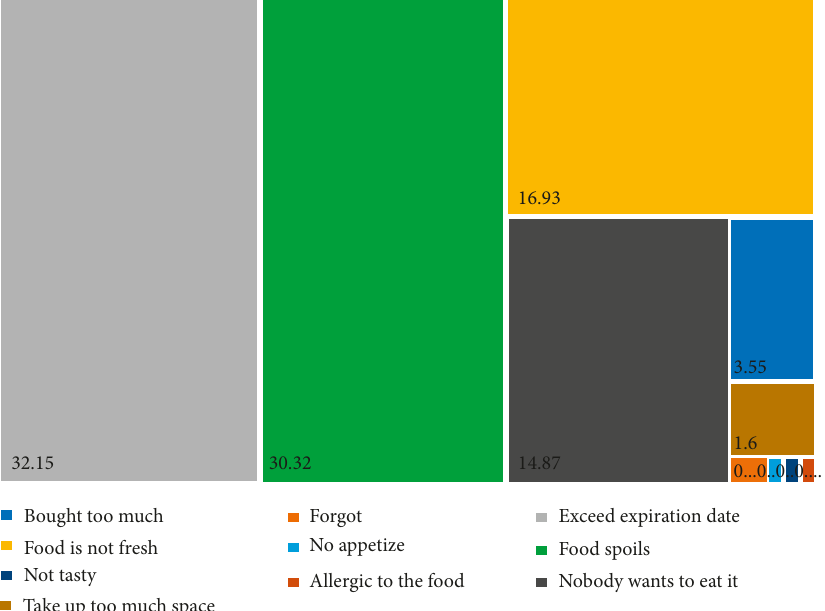
Figure 5: Reasons for food waste declared by